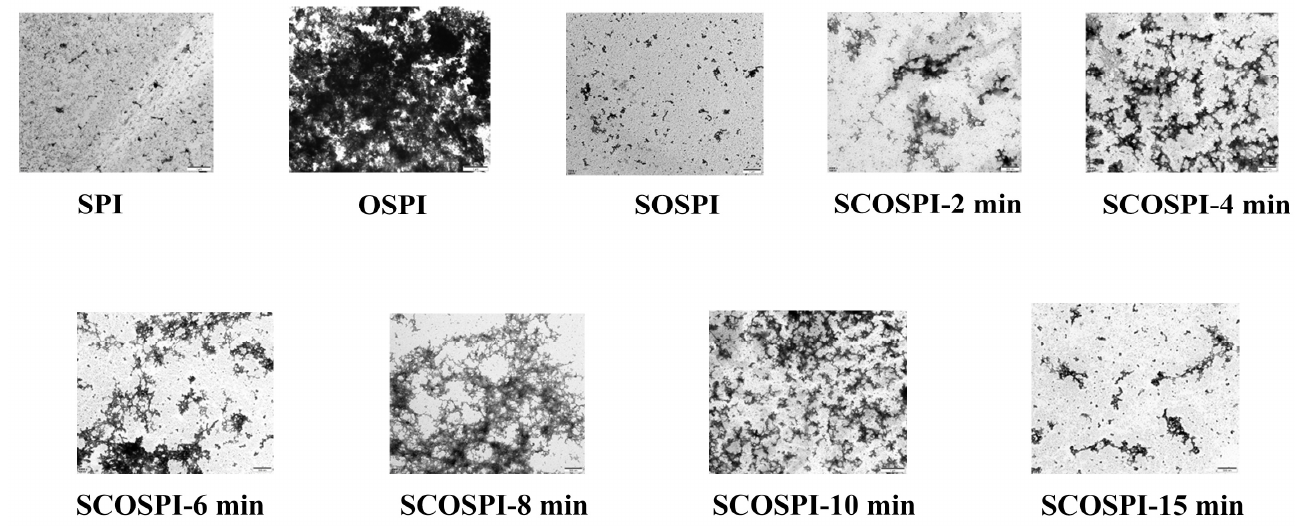
Figure 5. Backbone structure of natural, oxidized soybean protein, and cavitation jet treated on soluble soybean protein oxidized accumulates at several times (2, 4, 6, 8, 10, and 15 min).